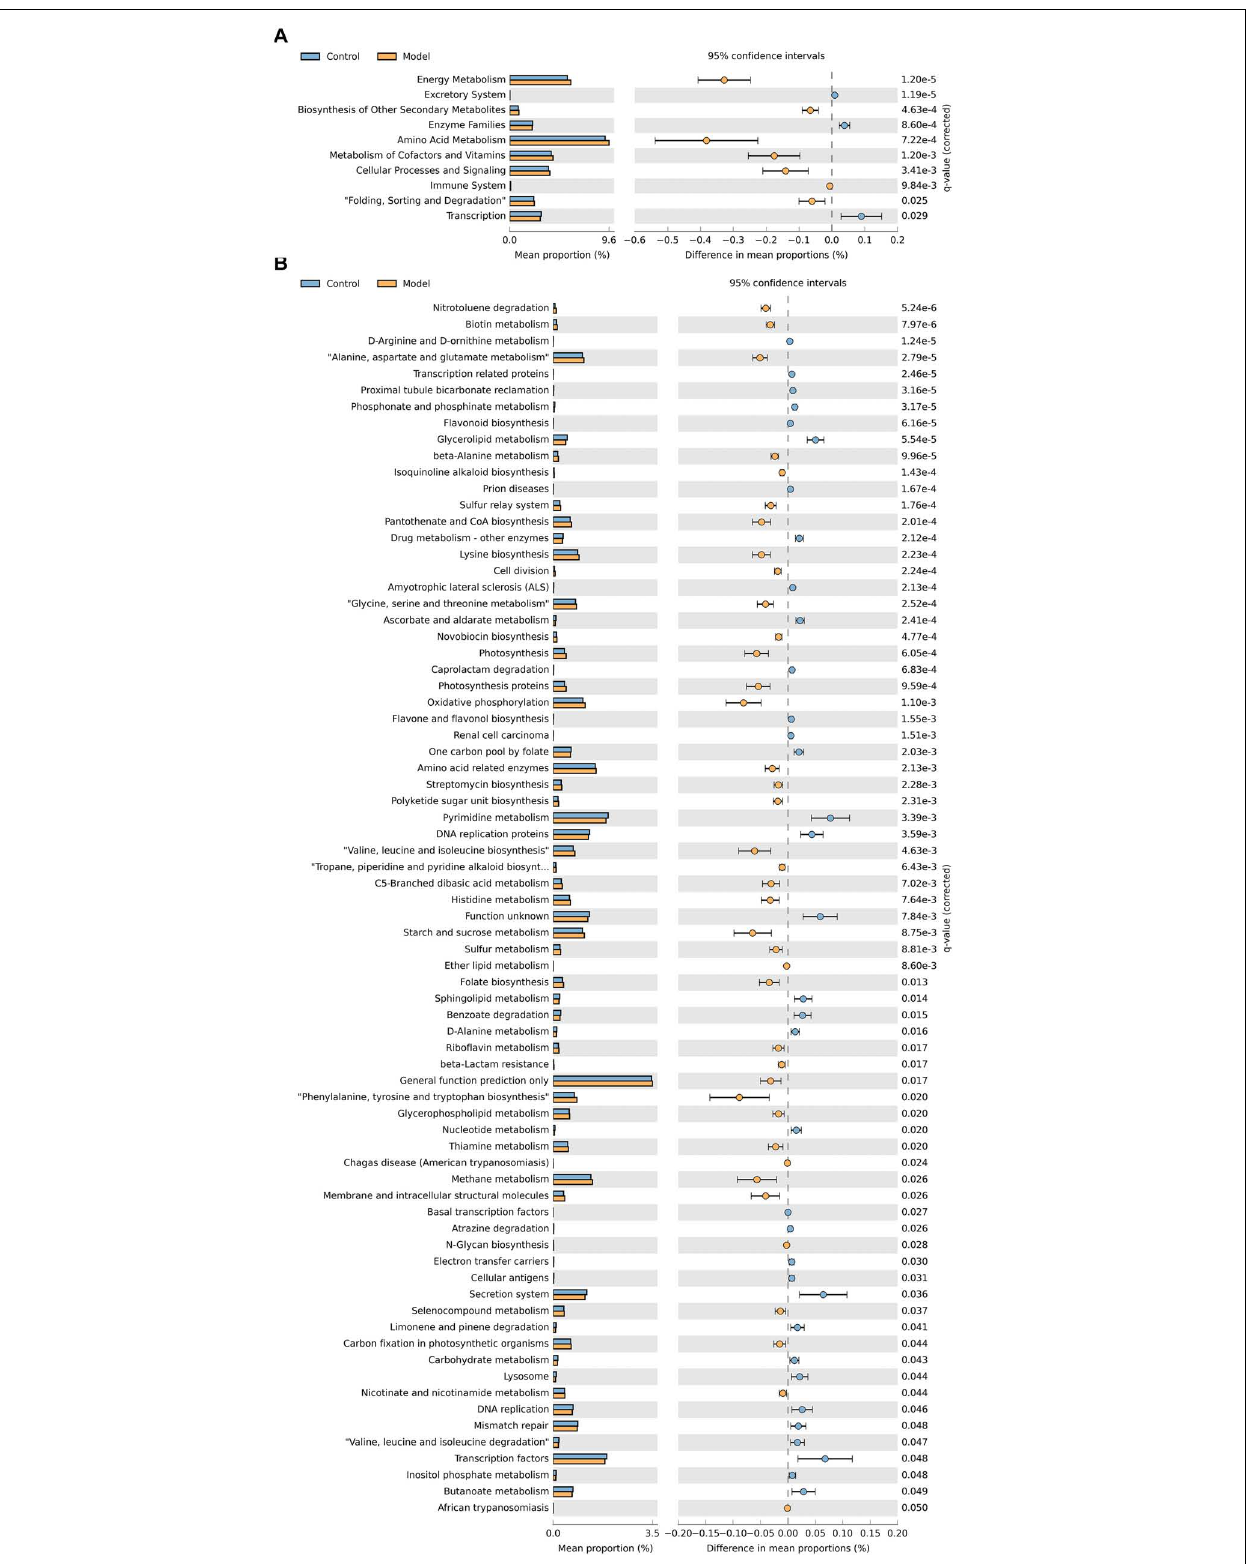
Frontiers in Microbiology |